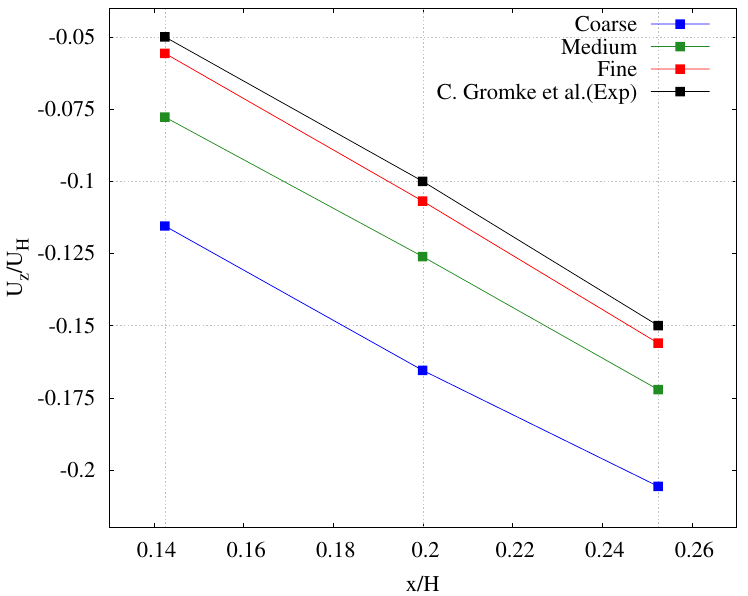
Figure 3. Mesh convergence study for the flow field validation. The three measurement points from the experiment of [35] were located on a horizontal line in the street canyon on a height of 0.7 H. The values on the ordinate are the normalized velocities in z-direction, with U H as the reference velocity at the inlet on the reference height H. Experimental data from [35], Elsevier,